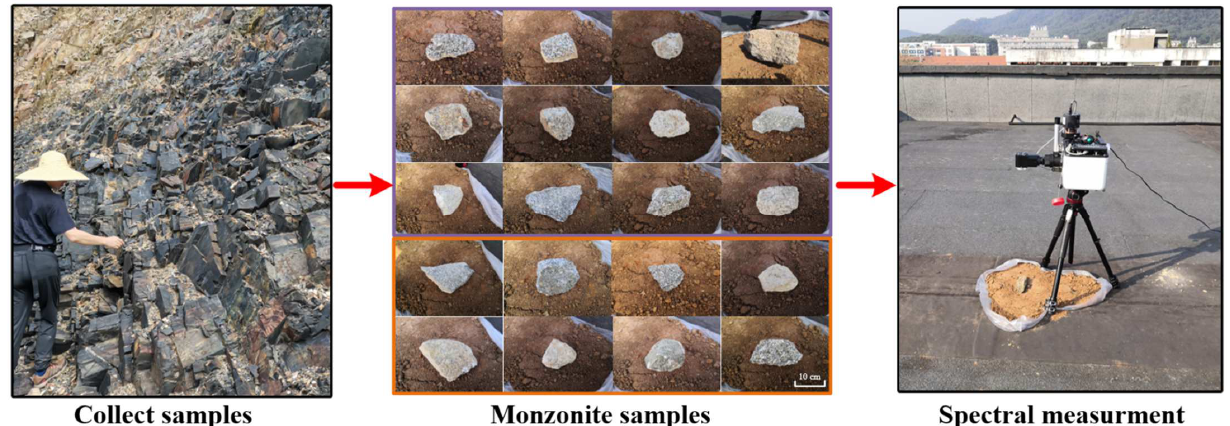
Figure 2. Process of spectral data collection.